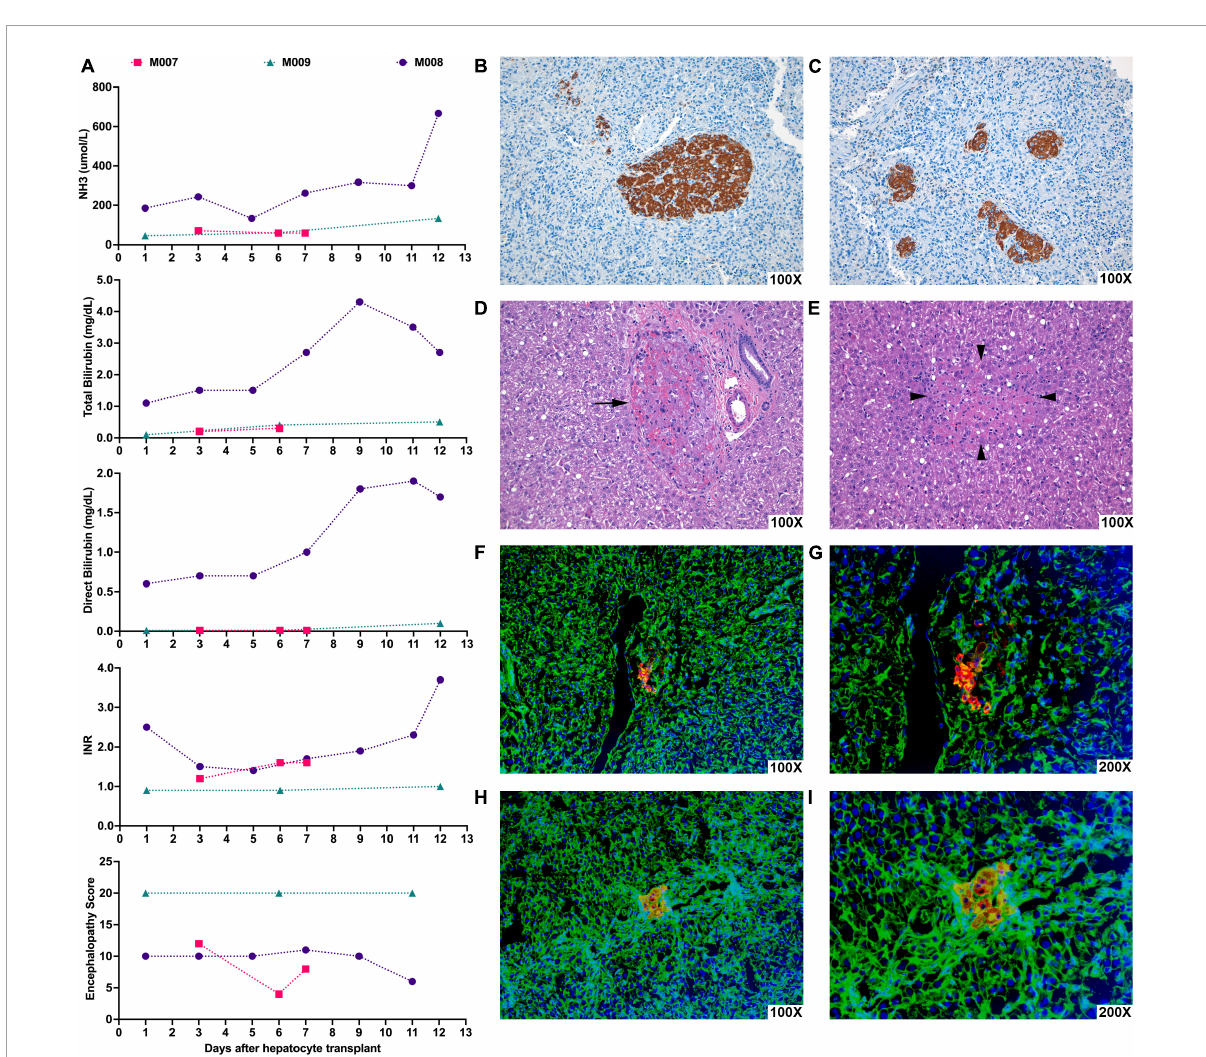
FIGURE3 Hepatocyte xenotransplantation into the spleen of NHPs with ALF appeared to show possible transient stabilization of hepatic function and led to engraftment of donor porcine hepatocytes in the recipient spleen and liver. NHPs underwent liver-directed radiation therapy and, after 2 weeks, were subjected to 90 min of hepatic I-R injury to induce ALF. At various timepoints after the induction of ALF, NHPs were transplanted with porcine hepatocytes. (A) Graphs show the changes in NH3, total bilirubin, direct bilirubin, INR, and encephalopathy scores in NHPs days after porcine hepatocyte transplant (day 0). M007 underwent I-R injury and hepatocyte transplantation on day 0 and was euthanized on day 7 due to renal failure. M008 received hepatocyte transplantation 83 days after hepatic I-R injury and survived for 12 days following the transplant but eventually expired from hepatic failure. M009 received hepatocyte transplantation 14 days after hepatic I-R injury and survived for 12 days but eventually succumbed due to respiratory distress from CMV pneumonitis. (B,C) Representative image of immunohistochemical staining for Hep Par-1 (brown) of recipient NHP spleen showing clusters of transplanted hepatocytes in the splenic parenchyma. (D) Representative photomicrograph of H&E stained recipient NHP liver showing a small group of donor hepatocytes within portal veins (arrows).